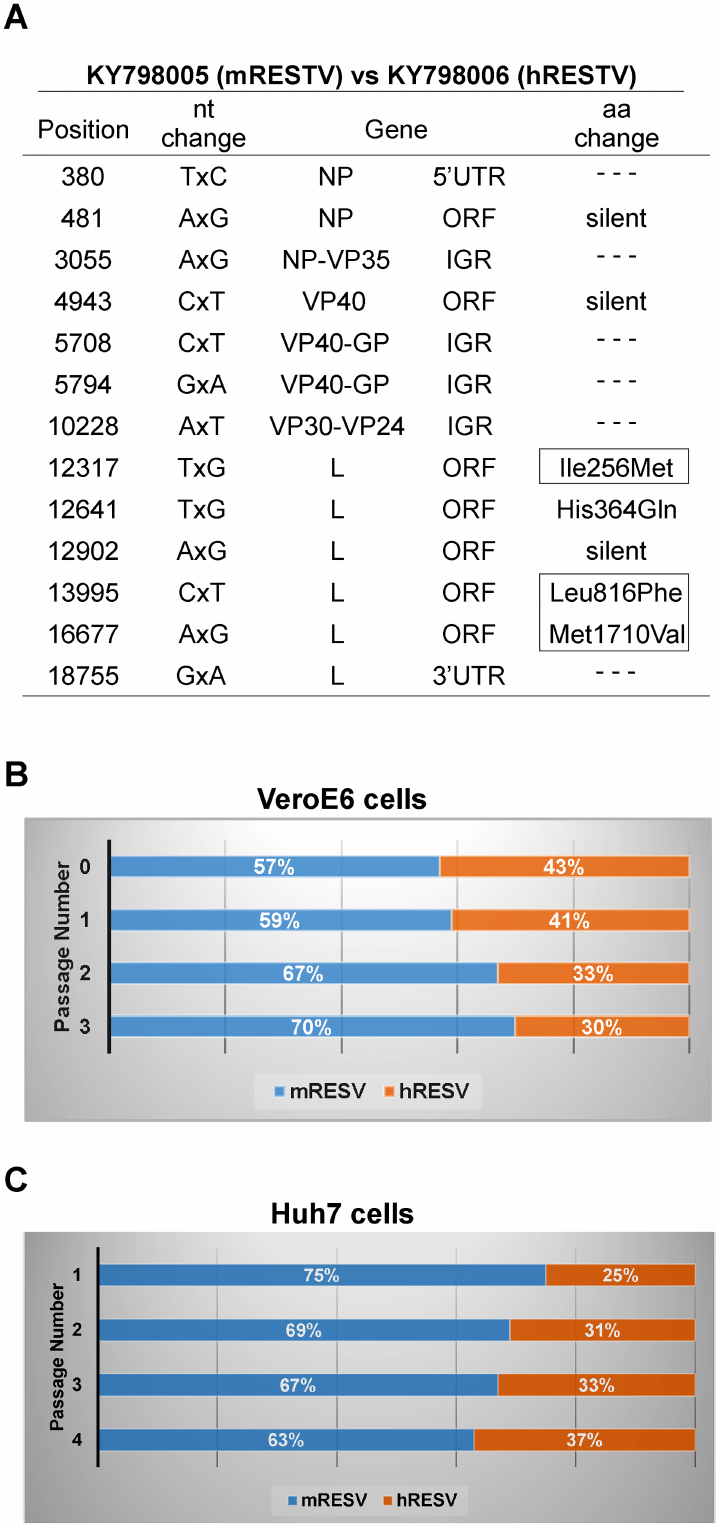
Fig 4. A. Sequencecomparisonof 2 viral isolates obtainedduringthe 1989 outbreakin Virginia, USA. The positionsof the nucleotide changes,gene locations,and amino acid changesare shown. Boxes are used